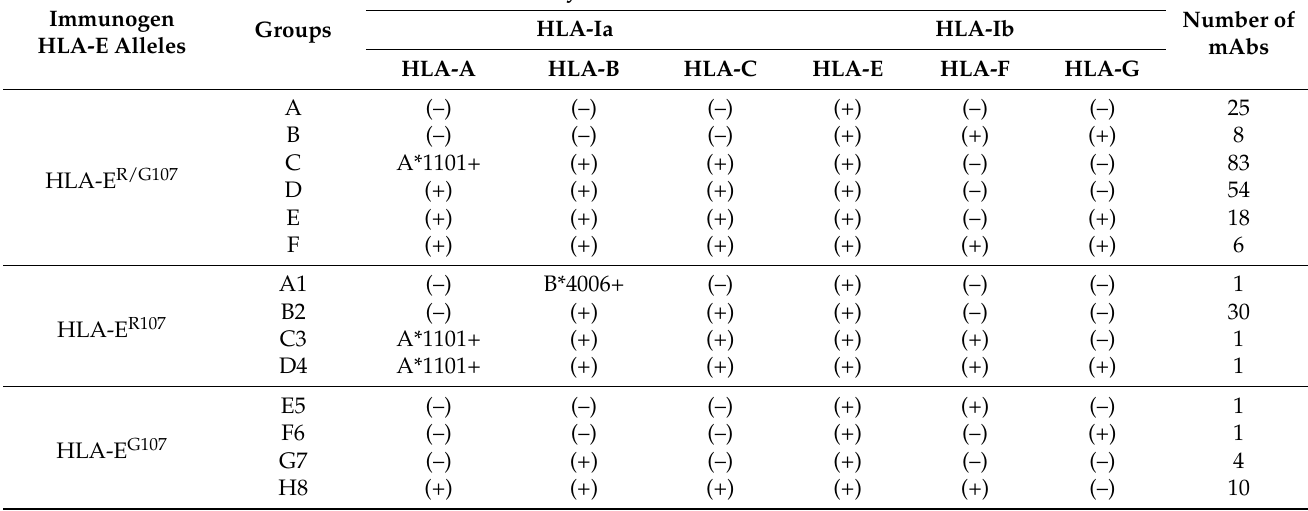
Table 6. HLA-I isoform reactivity of the monoclonal Abs generated against two alleles of recombinant β 2m-free HLA-E heavy chains